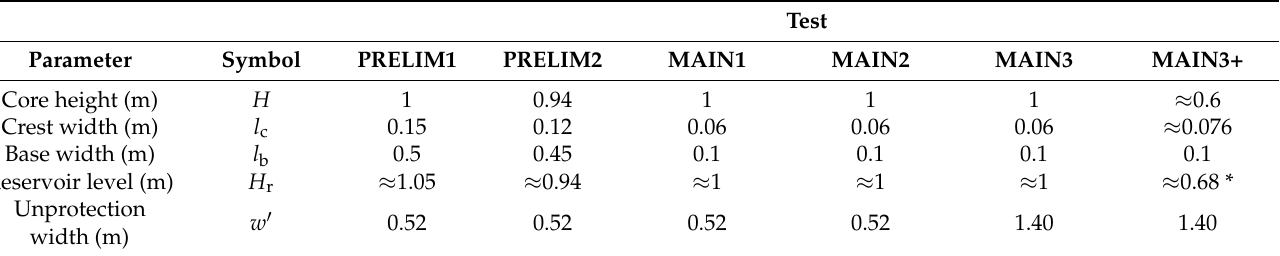
Table 4. Laboratory experimental set of tests.